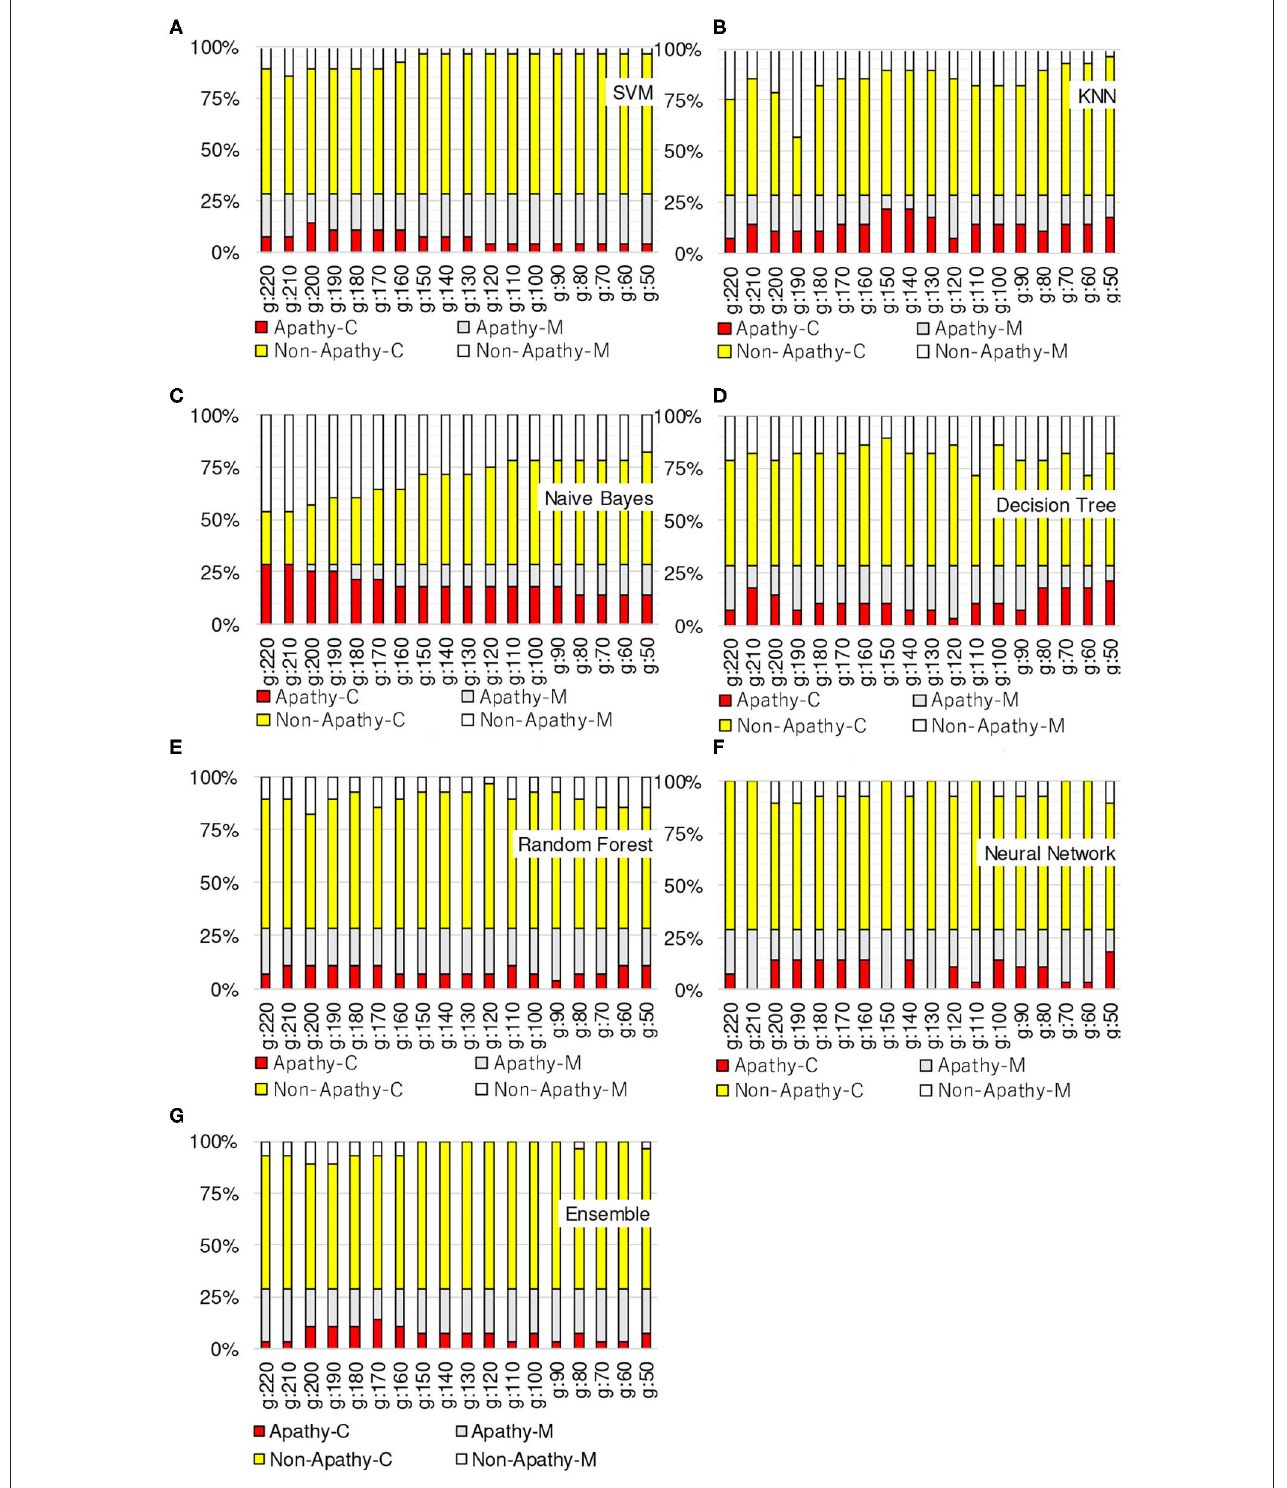
FIGURE 4 | Experimental results: using green channel. (A) SVM, (B) KNN, (C) Naive Bayes, (D) decision tree, (E) random forest, (F) neural network, (G) ensemble.